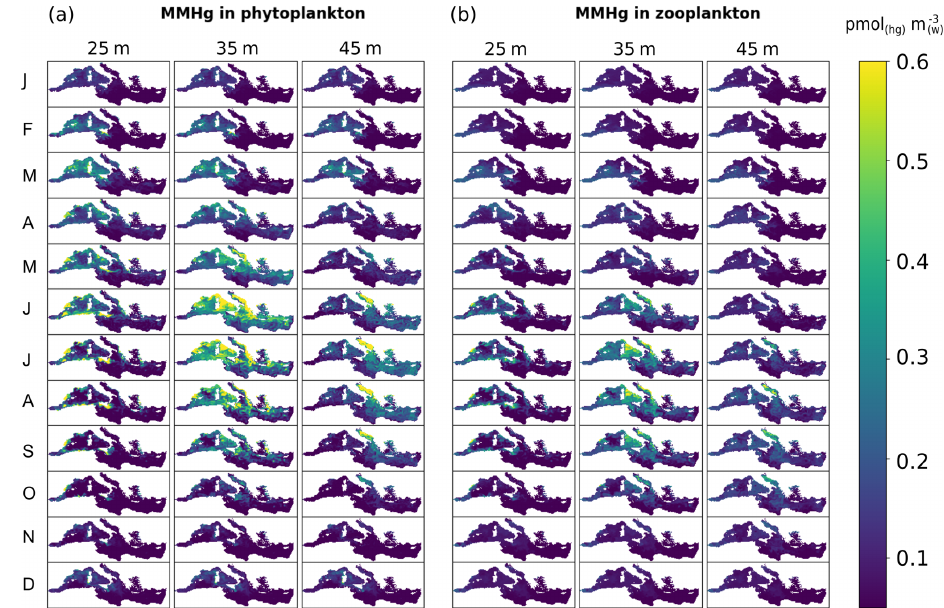
Figure 7. Spatial distribution of monthly averaged (a) MMHg phy and (b) MMHg zoo (pmol ( Hg ) m − 3 water depths (25, 35, and 45m) simulated with the OGSTM–BFM–Hg model for 2017. The plots show the sum of all variables of MMHg in phytoplankton (Figs. S7–S10) and zooplankton (Figs. S11–S14).